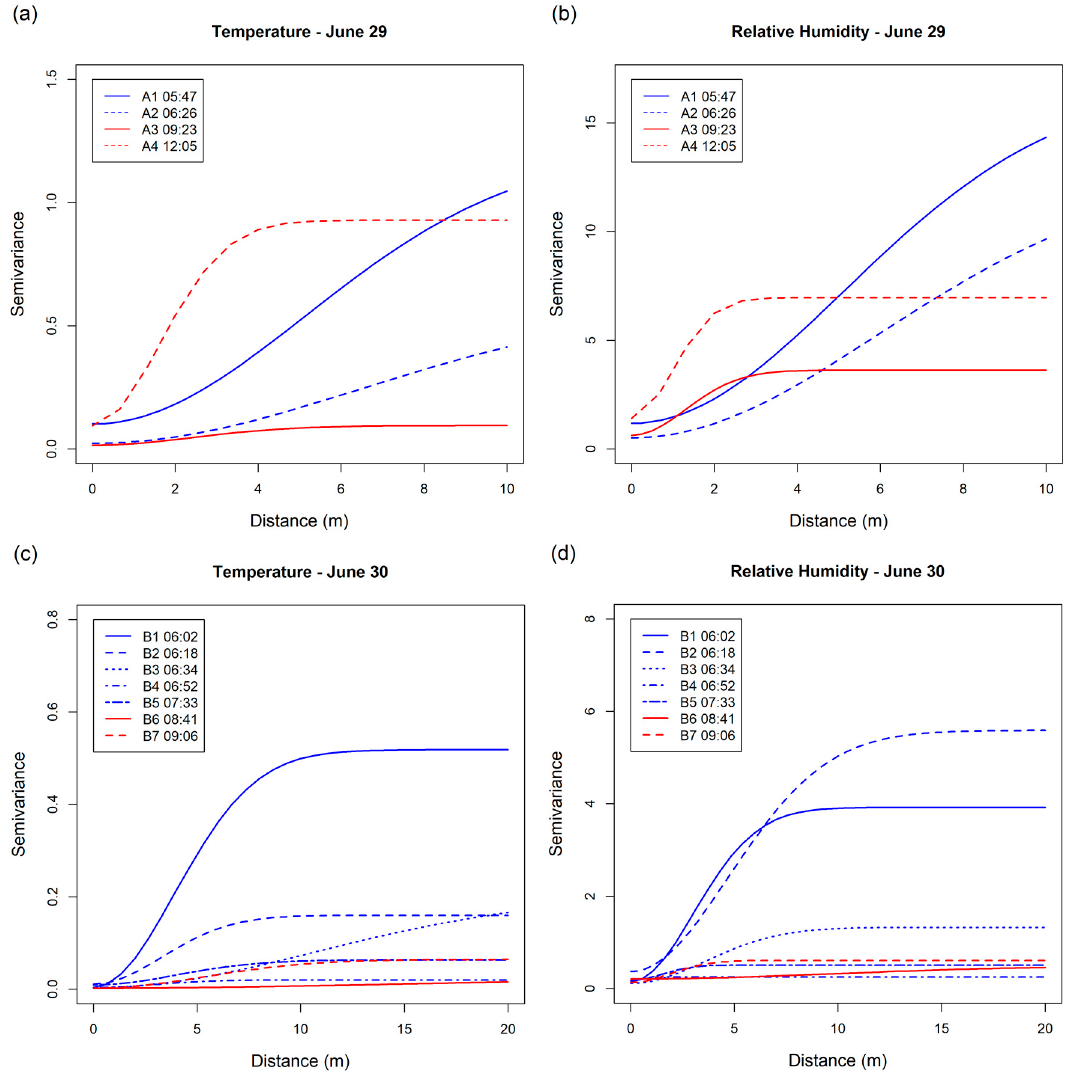
Figure 6. Fitted Gaussian variogram models for ( a ) June 29 temperature, ( b ) June 29 relative humidity, ( c ) June 30 temperature, and ( d ) June 30 relative humidity.